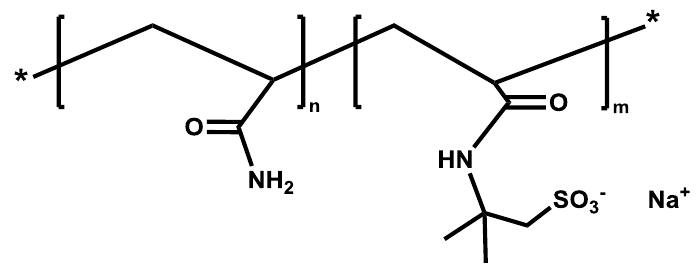
Figure 2. The molecular structure of sulfonated polyacrylamide polymers (AM/AMPS).